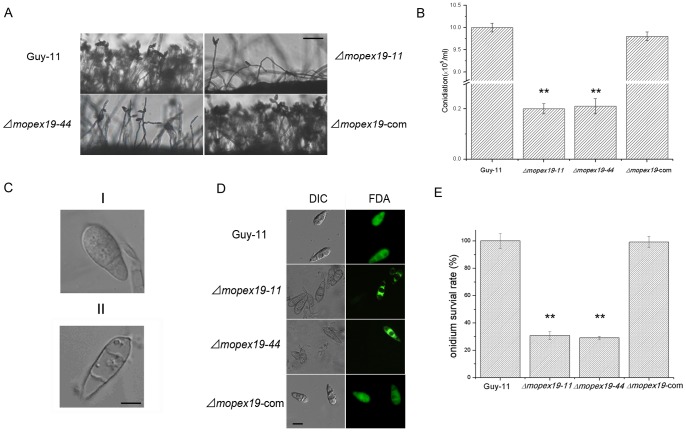

MoPEX19 deletion reduced the conidiation and conidial morphology and viability.(A) Wild-type, Δmopex19 and complemented strains cultured on CM for 7 days were examined by light microscopy. Bar = 50 μm. (B) Statistical analysis of conidia produced on CM culture at 28°C for 10 days. Means and standard errors were calculated from three independent repeats. Double asterisks indicate significant differences to the wild-type (P<0.01). (C) Normal (I) and nonviable conidia (II) of Δmopex19 under light microscopy. Bar = 10 μm. (D) Viable conidia stained with FDA emitted green fluorescence while the dead ones did not. Bar = 10 μm. (E) Statistical analysis of viability of conidia cultured on CM at 28°C for 10 days. Means and standard errors were calculated from three independent repeats (at least 150 conidia of each strain were measured for each repeat). Double asterisks indicate significant differences to the wild-type (P<0.01).